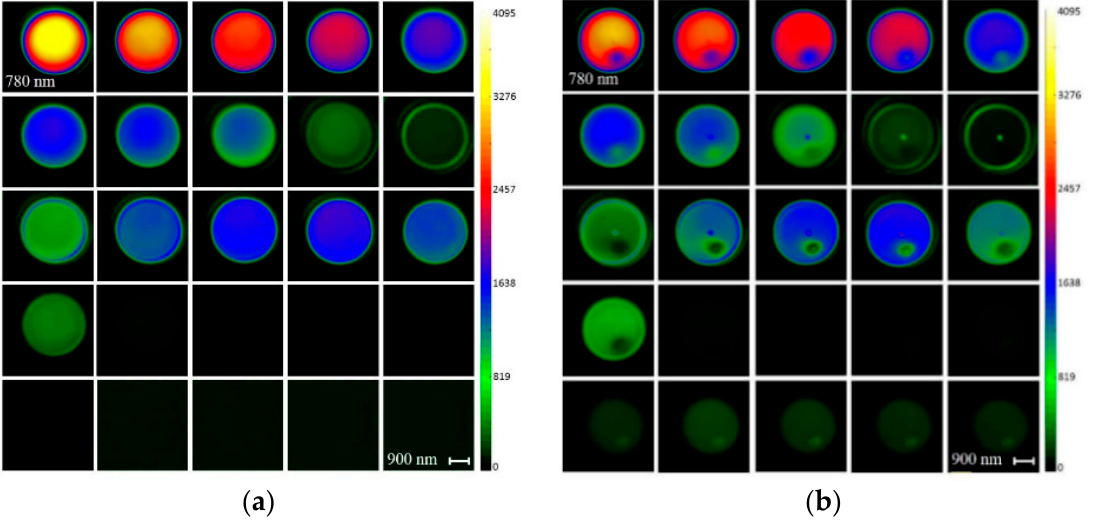
Figure 8. Spectrally resolved OBIC for ESD detection. ( a ) Normal and ( b ) Spectrally resolved OBIC image of the EDS-HBM VCSEL [64]. Reprinted with permission from ref. [64] © The Optical Society. Copyright 2021 OSA Continuum.